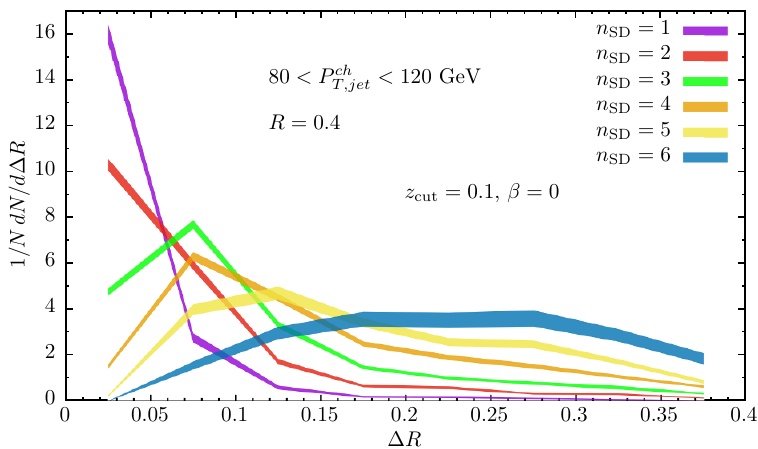
Figure 10 . The distributions of the angular separation (cid:1) between the two subjets identi(cid:12)ed via the (cid:12)rst Soft Drop splitting satisfying (4.1) for jets in vacuum with di(cid:11)erent total numbers of Soft Drop splittings, or n SD